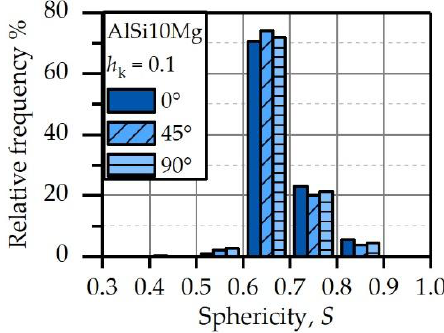
Table 3. Results of the quasi-static tensile tests of AlSi10Mg specimens.